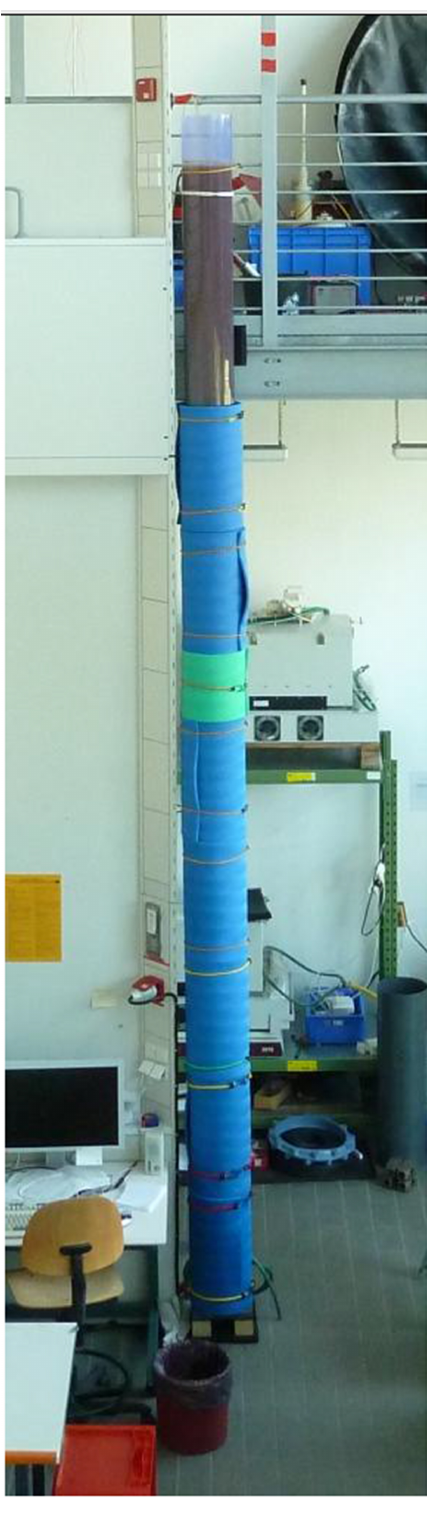
Figure 3. Initial conditions of the water column experiment: brown- ish monimolimnion water in a PVC pipe, thermally insulated by PE matrasses. Uppermost matrasses were removed for the purpose of this